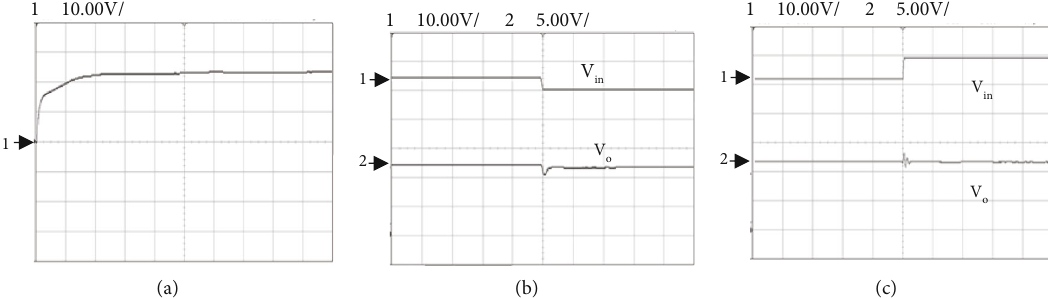
Figure 19: Experimental V responses of FKYBC with HPC: (a) transient state, (b) input voltage change from 16 V to 12 V, and (c) V o change from 16V to 18V [Ch 1: 10 V/Div, Ch 2: 5V/Div].